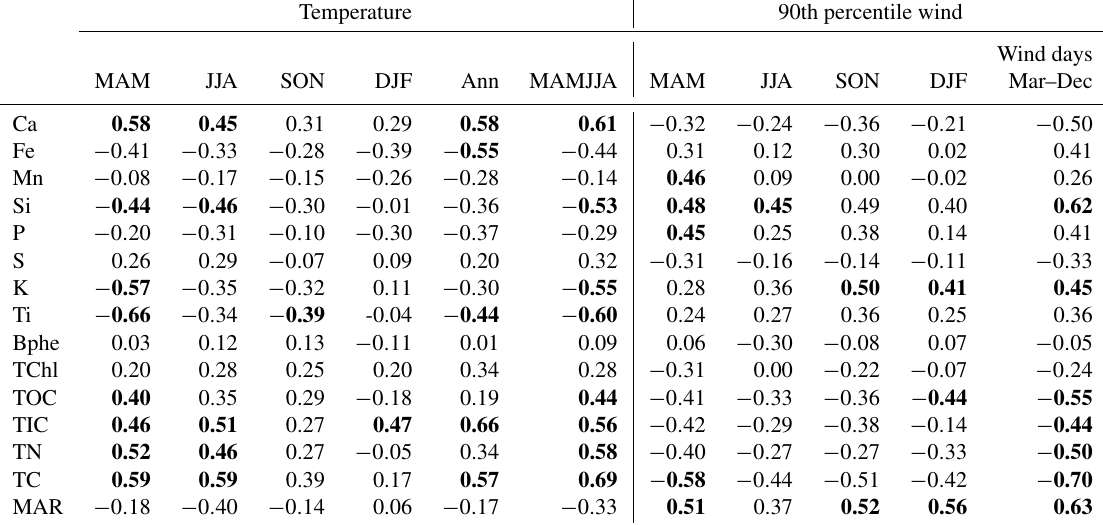
Table 1. Correlation matrix of Pearson correlation coefficients for selected meteorological variables and data from varves (annual mean values of geochemical data). Bold values indicate significant correlations ( p adj < 0 . 05). The p values were corrected for autocorrelation (Bretherton et al., 1999) and the false discovery rate (Benjamini and Hochberg,